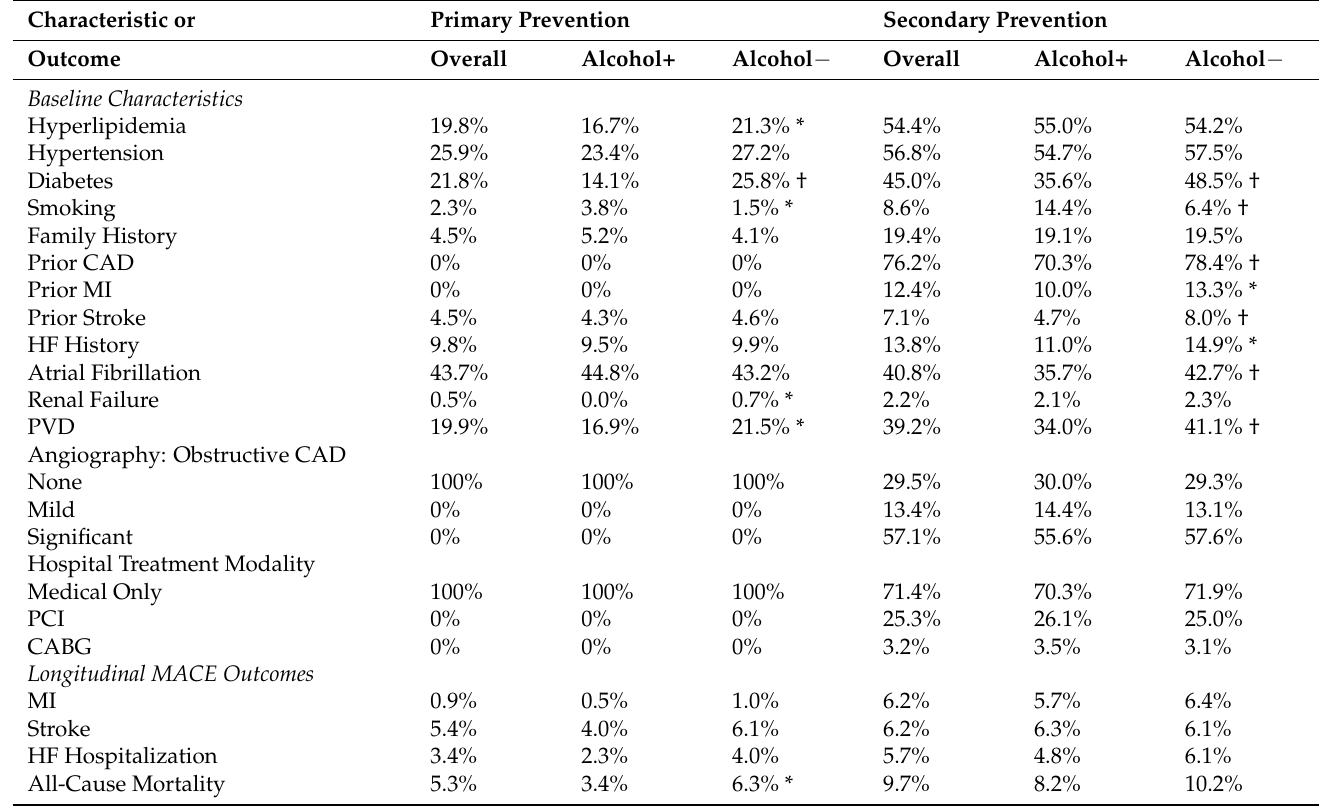
Table 3. Major coronary risk factors and baseline history of MACE by primary or secondary preven- tion